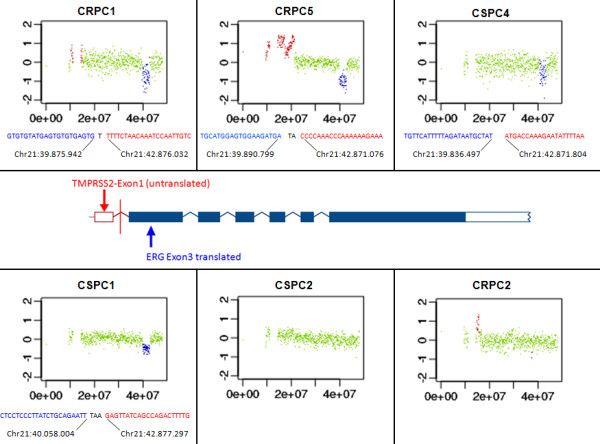
Identification of the TMPRSS2-ERG associated 3-Mb deletion on chromosome 21 and mapping of the breakpoints. Exemplary log2 ratio plots of chromosome 21 from plasma DNA of several patients (regions with log2 ratios >0.2 are shown in red and those with log2 ratios <-0.2 in blue). A deletion with size of 3 Mbp located at the TMPRSS2-ERG region was visible in patients CRPC1, CRPC5, CSPC4, and CSPC1. For comparison we also included chromosome 21 plots from CSPC2 and CRPC2 without this deletion. Mapping of the exact breakpoints was based on fusion transcripts identified with our GB-panel. In CRPC1, CRPC5, and CSPC4 the breakpoints were in exon 1 of the TMPRSS2 gene and exon 3 of the ERG gene, respectively (center panel). In CSPC1 the proximal breakpoint was approximately 24 Kb upstream of the ERG gene.